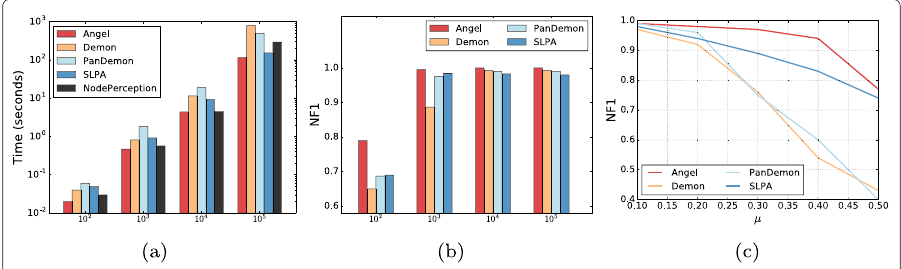
Fig. 4 Synthetic Benchmarks. a Running time of the compared algorithms w.r.t. network size (number of nodes); b Avg. community resemblance score per network size; c Community resemblance varying LFR mixing coefficient (number of nodes 10 6 ). In ( b - c ) the NF1 scores for N ODE P ERCEPTION are omitted due to their low values (NF1 ≤